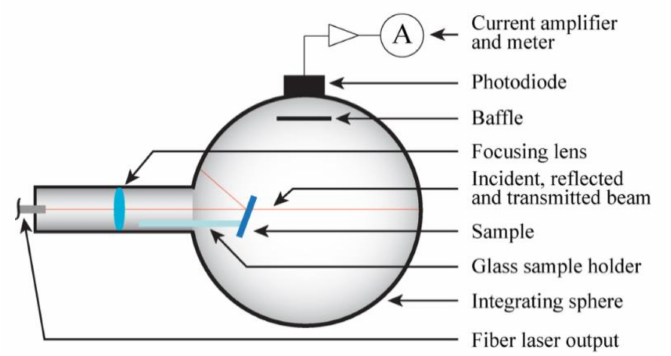
Figure A1. Schematic representation of the absorption measurement setup. The light source was a tunable filtered supercontinuum laser and the sample was inserted into the integrating sphere at an angle to keep the specular reflection inside the